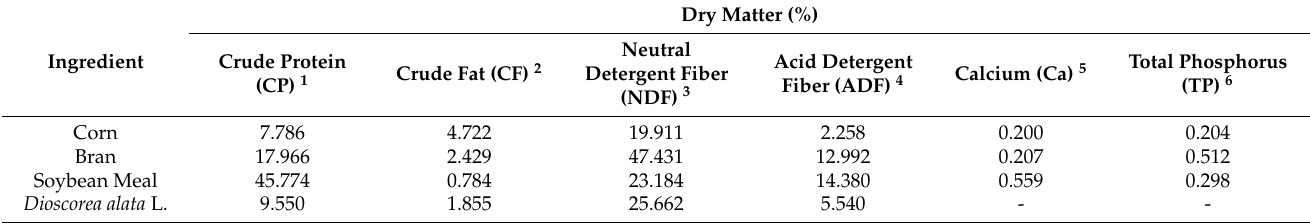
Table 1. Main nutrients in feed.